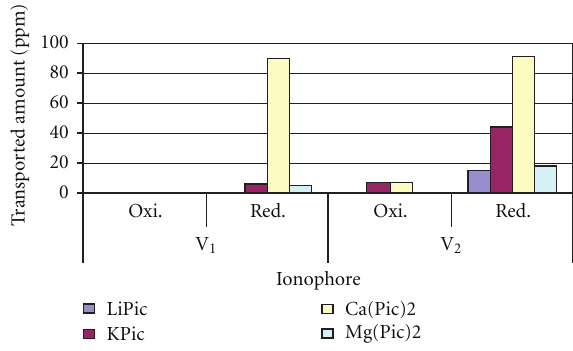
Figure 6: Transport of metal ions using ionophores V 1 and V 2 .